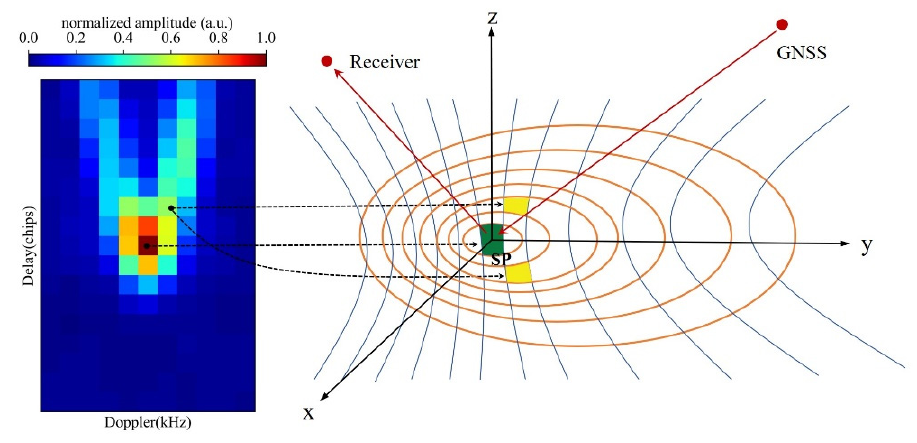
Figure 2. Illustration of the DDM and corresponding surface reflections.